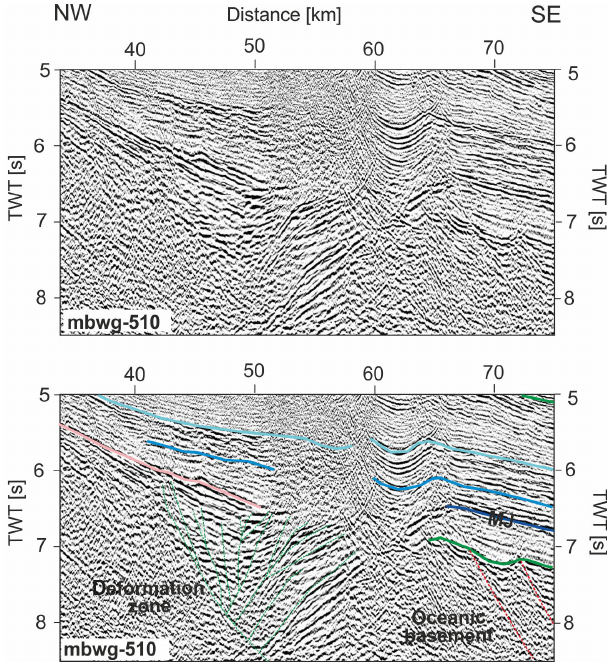
Figure 5. Close-up view of the zone of deformed basement in the Mozambique Basin presented in Fig. 4. The lower panel shows the interpreted section of the profile. The basement is deformed by steeply dipping, fan-like normal faults that at depths converge into a single, subvertical fault (green, profile distance: 40–60km). The overall geometry of the deformation resembles a negative flower structure. Unconformity MJ has an inferred age at the transition from the Middle to Late Jurassic and the blue sedimentary horizons indicate Late Jurassic and Middle Cretaceous